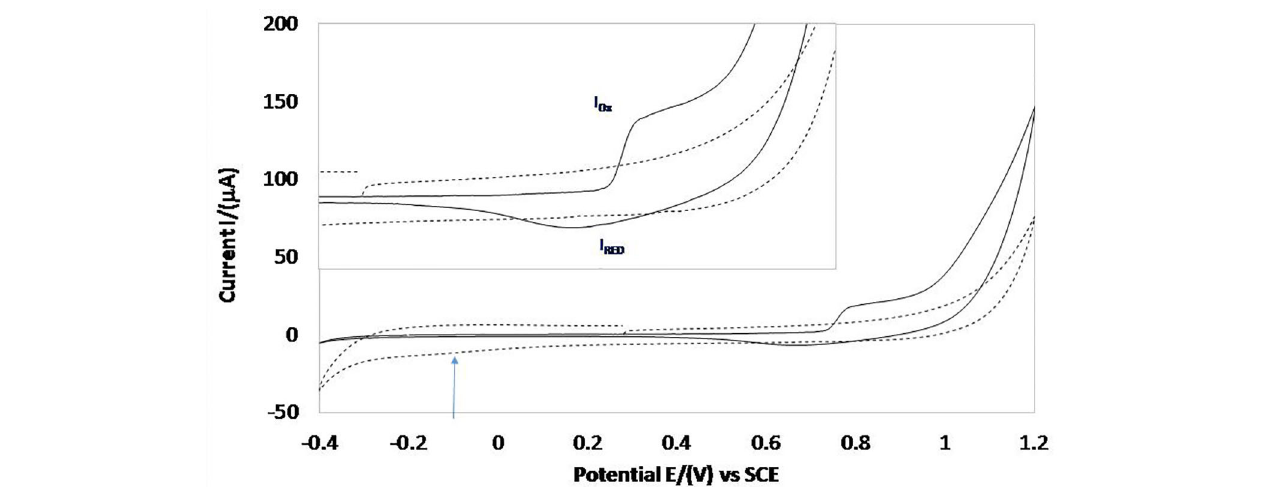
FIGURE 6 | Cyclic voltammetry of MCPE with different positive inversion potentials (E λ + ) in an electroactive range of 350–1200mV, evaluating every 50mV, at a scan rate of 25mVs − 1 .